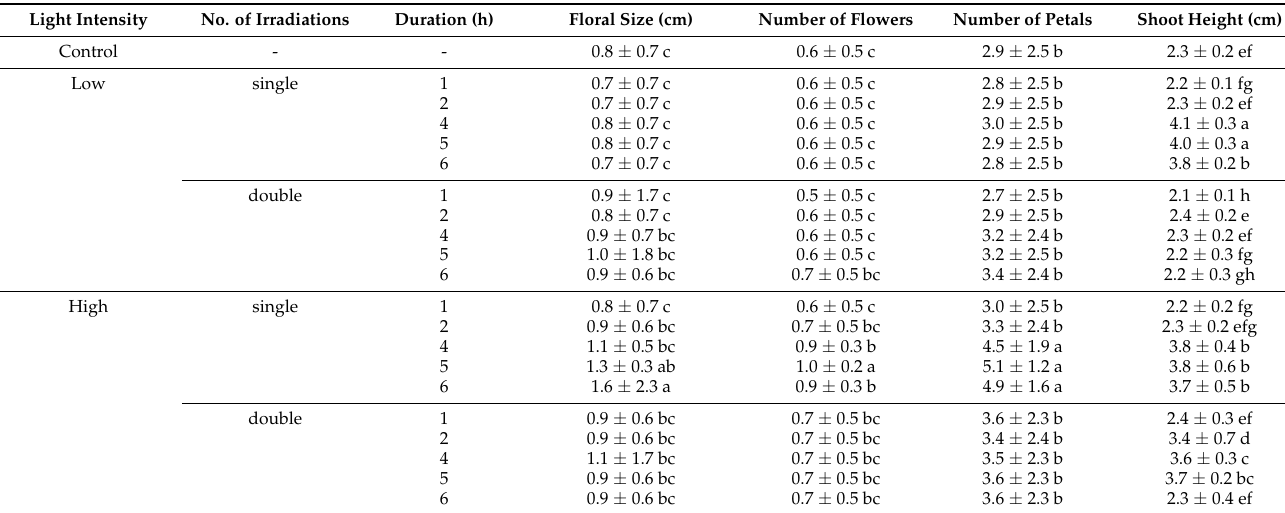
Table 3. Effect of low- and high-intensity UV-C with single or double irradiation for various durations on Persian violet floral size, number of flowers, number of petals, and shoot height after subsequent culturing for 8 weeks. Light Intensity No. of Irradiations Duration (h) Floral Size (cm) Number of Flowers Number of Petals Shoot Height (cm) Control - - 2.9 ± 2.5 b 2.3 ± 0.2 ef Low